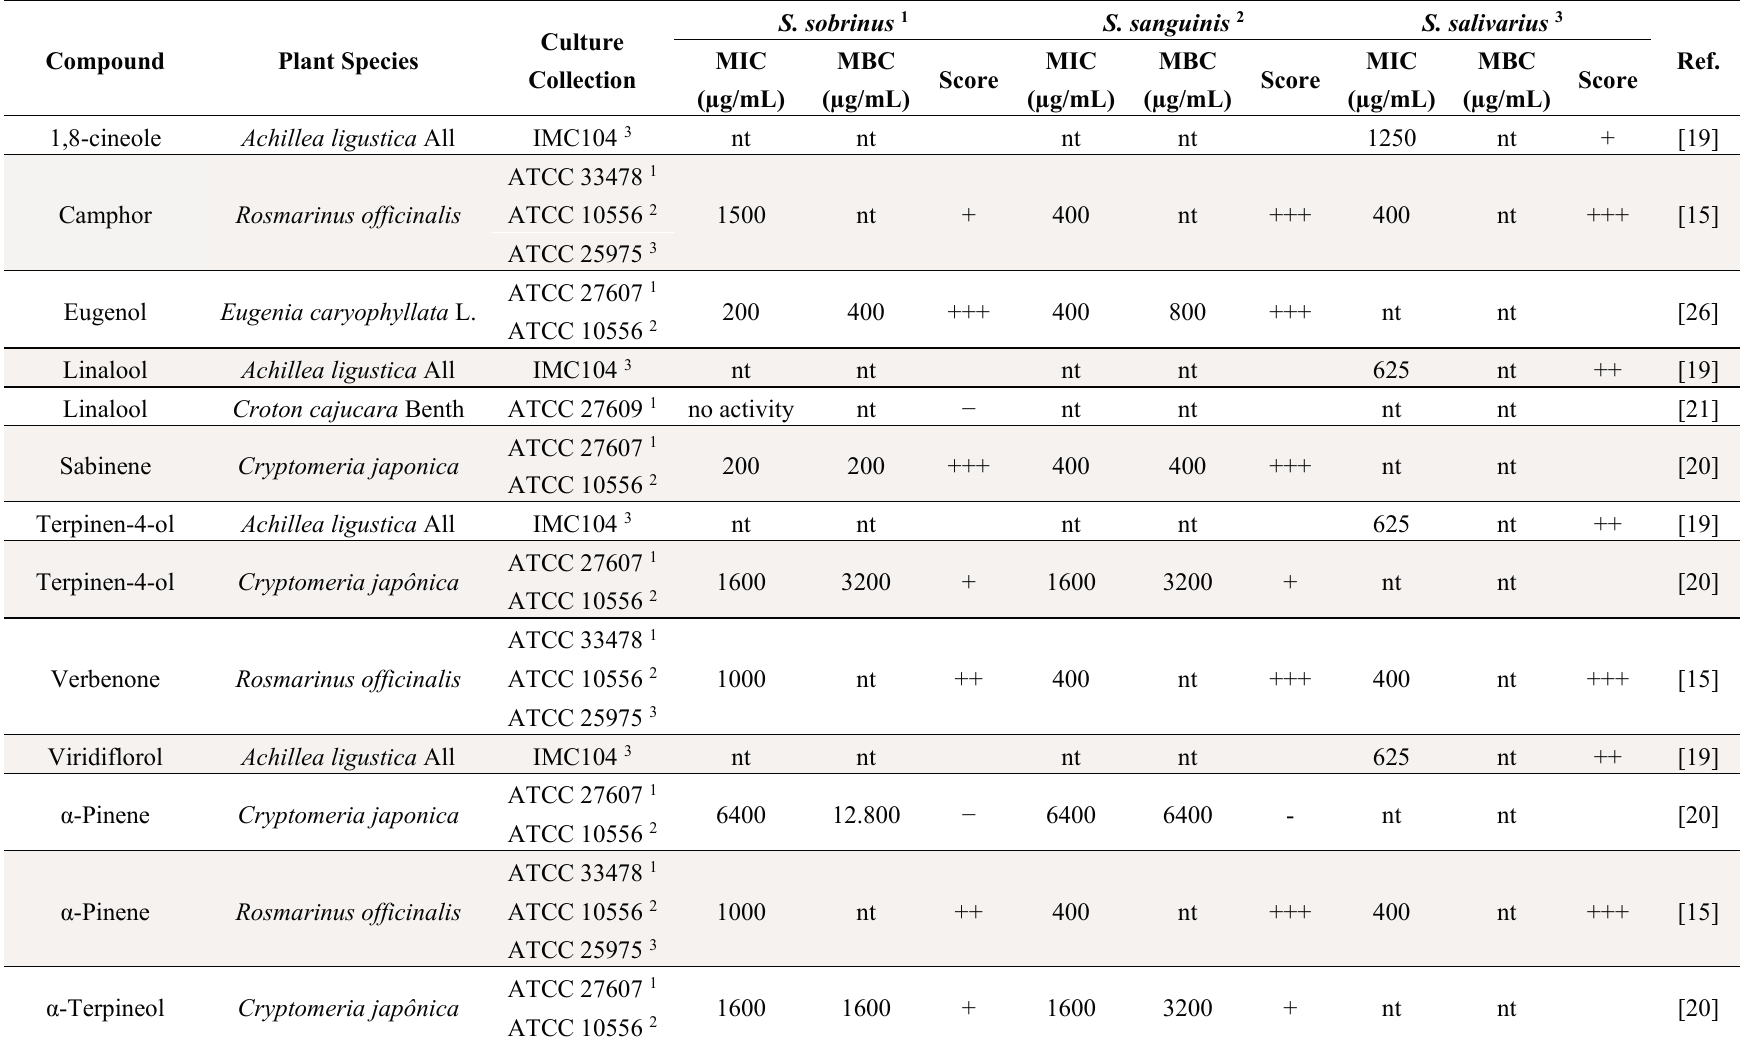
Table 6. Essential oils isolated compounds against S. sobrinus , S. sanguinis and S.